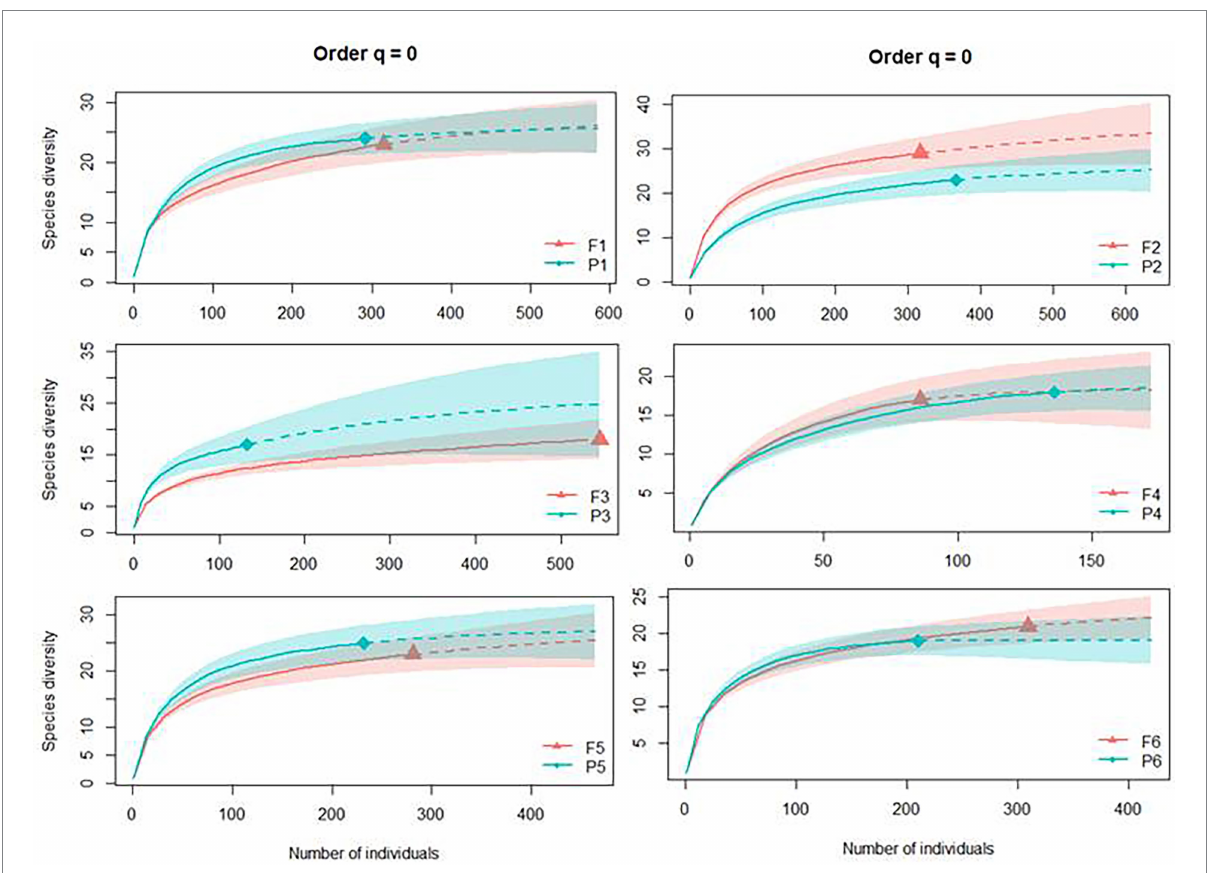
FIGURE 3 Individual-based rarefaction (solid lines) and extrapolation (dashed lines, up to double the smallest sample size) of dung beetle species richness for Hill number (q = 0) for each site, where F represents native forests and P represents Pinus